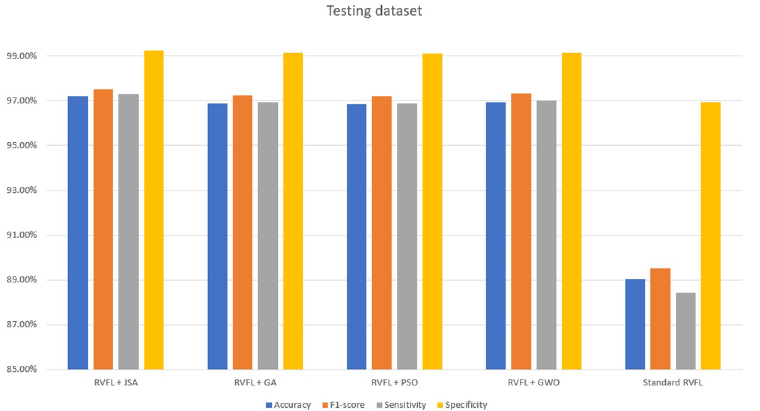
Fig 6. Accuracy, macro F1-score, sensitivity, and specificity for the training dataset.